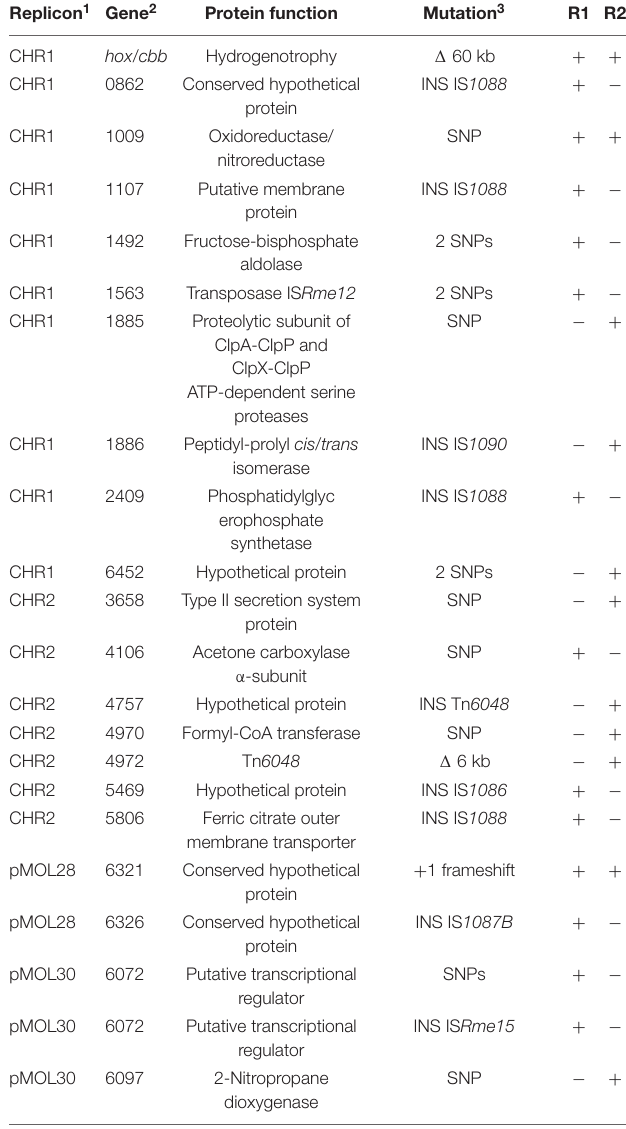
TABLE 5 | Identified mutations in CH34-TIMM R 1 (R1) and CH34-TIMM R 2 (R2). Replicon 1 Gene